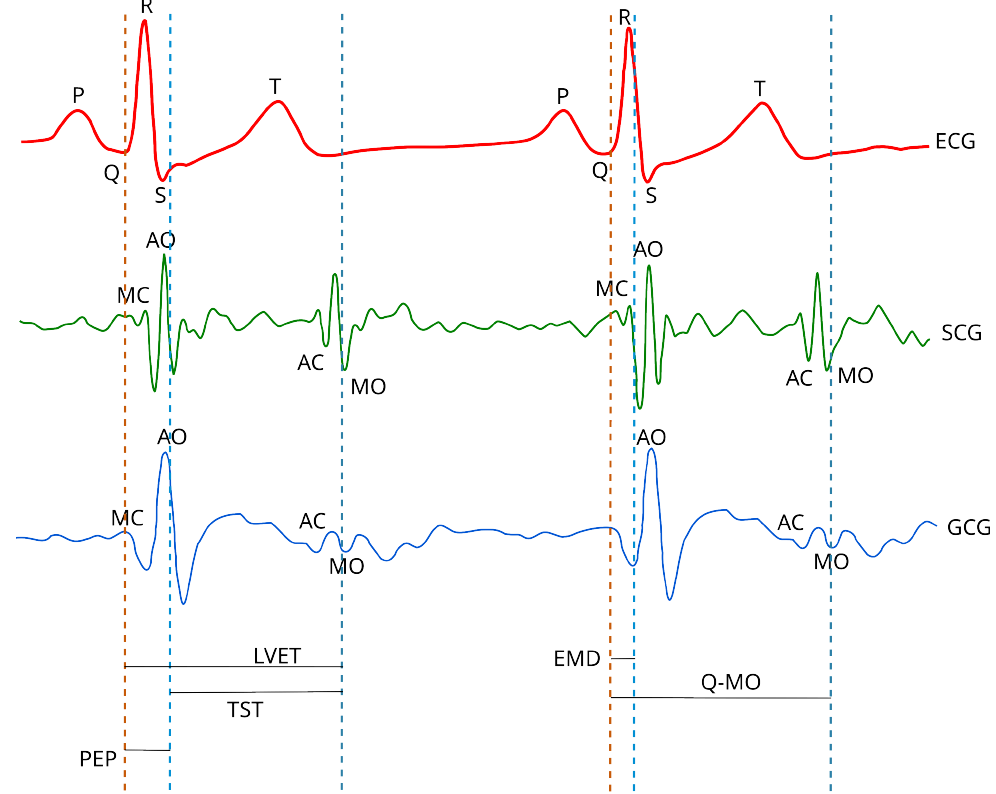
Figure 1. The annotation of ECG, SCG and GCG waveforms in healthy subjects. Based on the diagrams published in [15,18,26,29] under the CC-BY 4.0